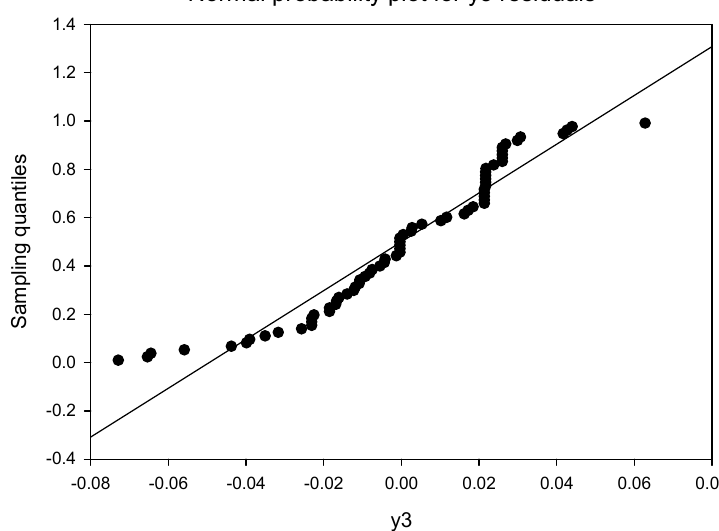
Figure A1. Histogram of residuals: ( a ) The normal probability plot for motor efficiency ( 3 y ) is shown on Figure A2. Normal probability plot for y3 residuals